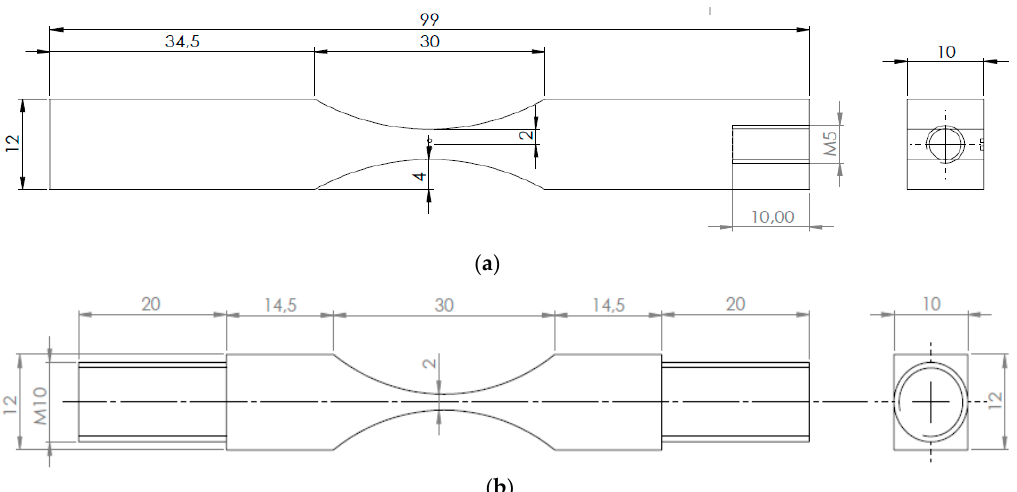
Balance Table 2. Main mechanical properties of aluminum alloy 7075-T6.